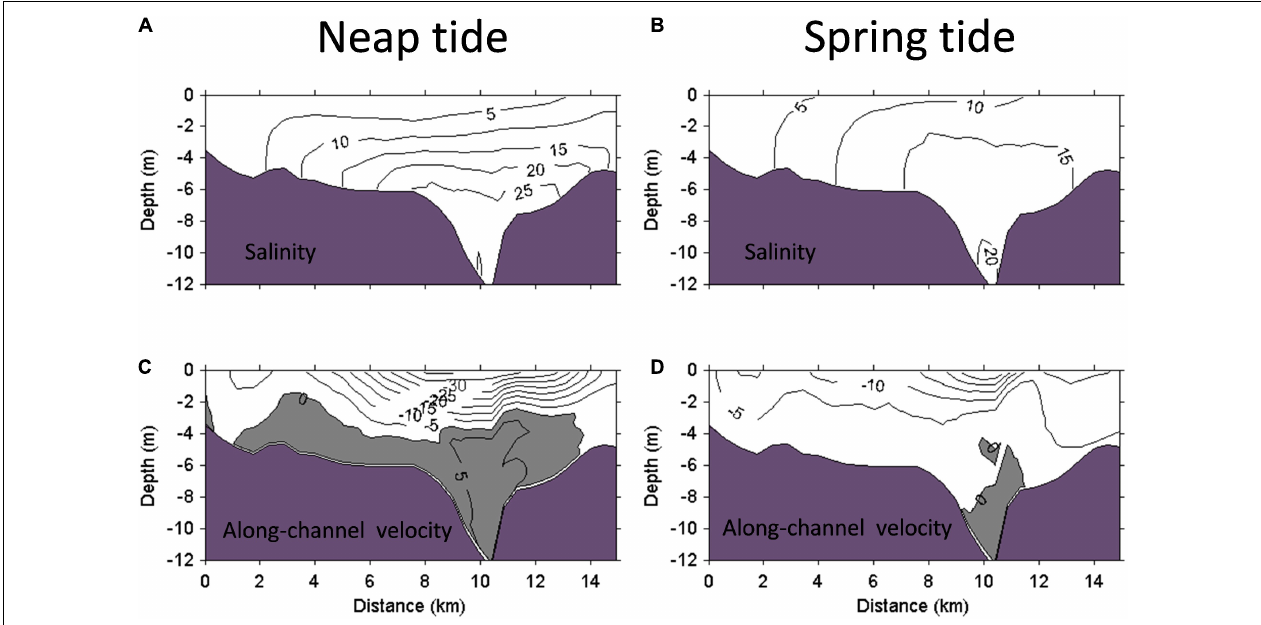
FIGURE 2 | Model simulated subtidal salinity at maximal neap (A) and spring (B) tides and along-channel current velocity (cm/s) at maximal neap (C) and spring (D) tides along the cross-channel section S. The positive velocity indicates along-channel landward current. The x-axis represents the distance from the west shoal to the east shoal as one looks into the